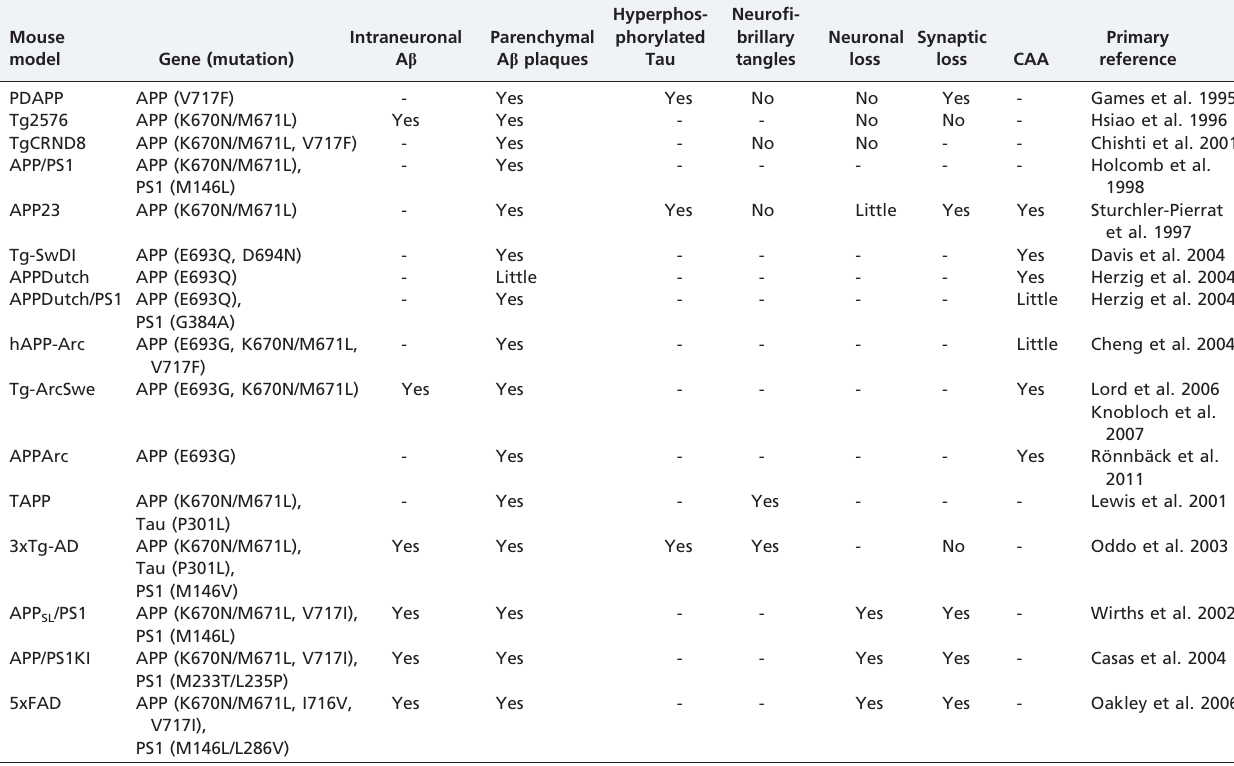
Table 1 - Neuropathological features of the main transgenic mouse models of Alzheimer disease. Mouse